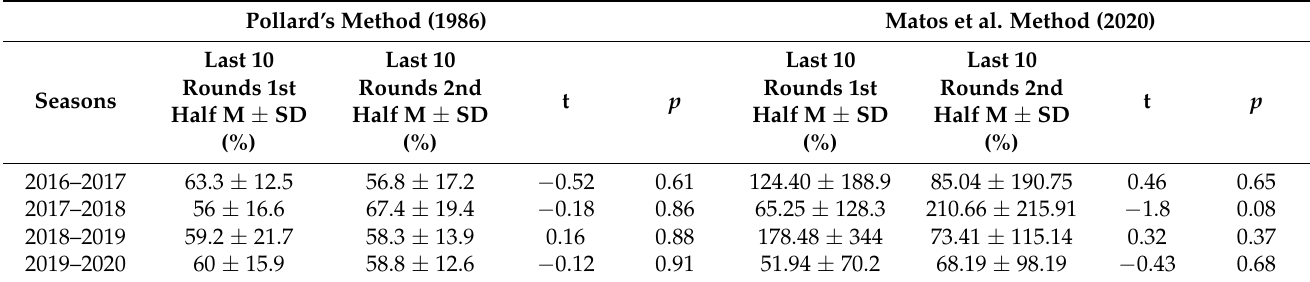
Table 2. Comparison of home advantage between last 10 rounds of first and second half of the double round-robin competition. Pollard’s Method (1986)